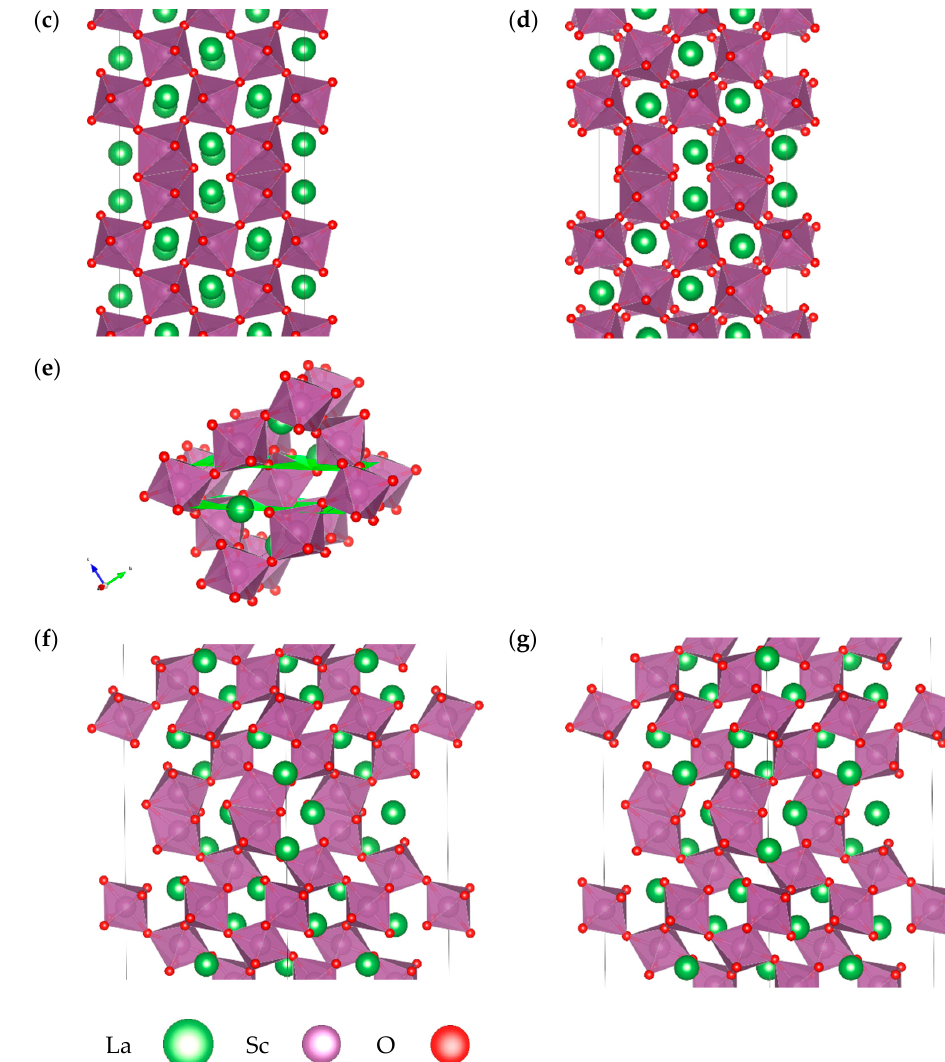
La Sc O Figure 1. (100) ( a ), (121) ( b ), and (011) ( e ) planes and, respectively, antiphase boundaries in them ( c , d , f , g ).